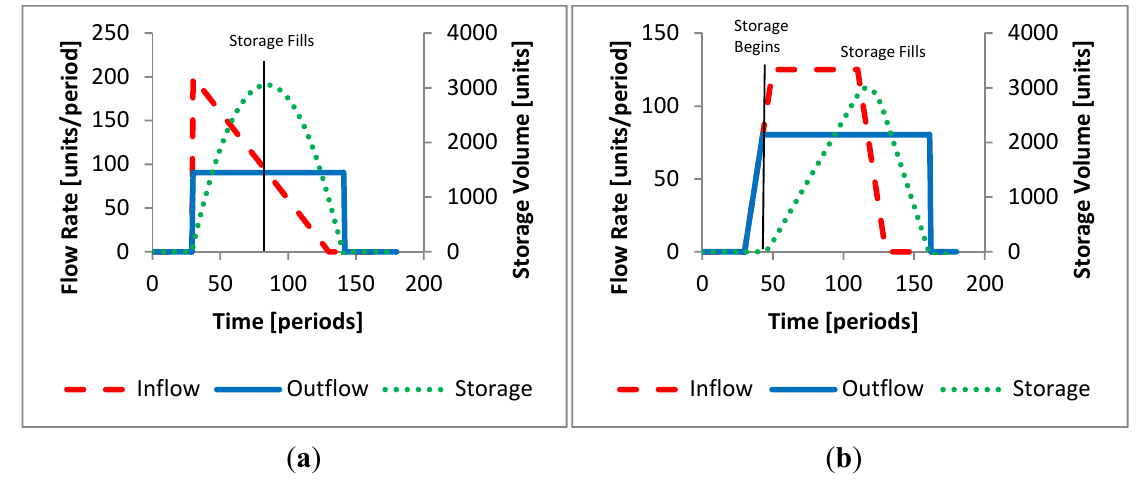
Figure 2. Minimize flood peak with perfect forecasting for ( a ) Abrupt wave hydrograph and ( b ) Broad peak hydrograph.